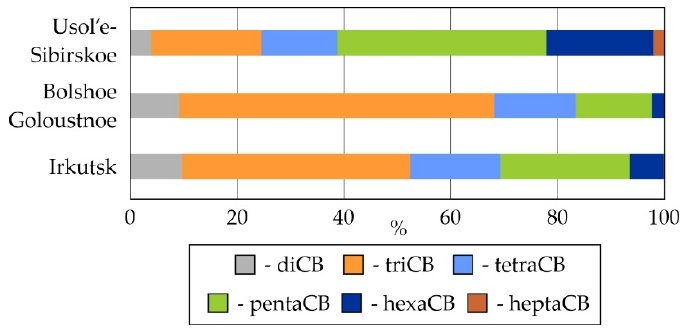
Figure 10. The contribution of PCB homologues in total PCB annual deposition flux (%).